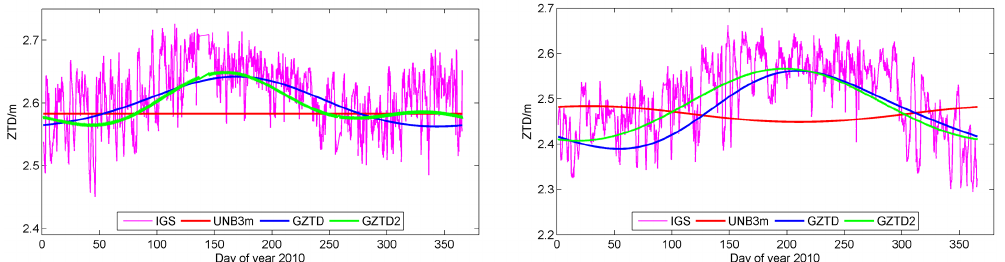
Figure 12. ZTDs at IGS station KOUR (5.3 ◦ N, 52.8 ◦ W, 9.5ma.s.l.; left) and IGS station TWTF (24.9 ◦ N, 121.2 ◦ E, 189.9ma.s.l.; right) as provided by IGS and as estimated by different models over the year